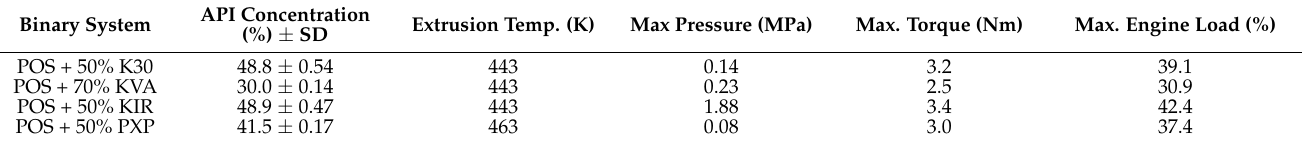
Table 1. HME process outputs for POS + K30, POS + KVA, POS + PXP, and POS + KIR